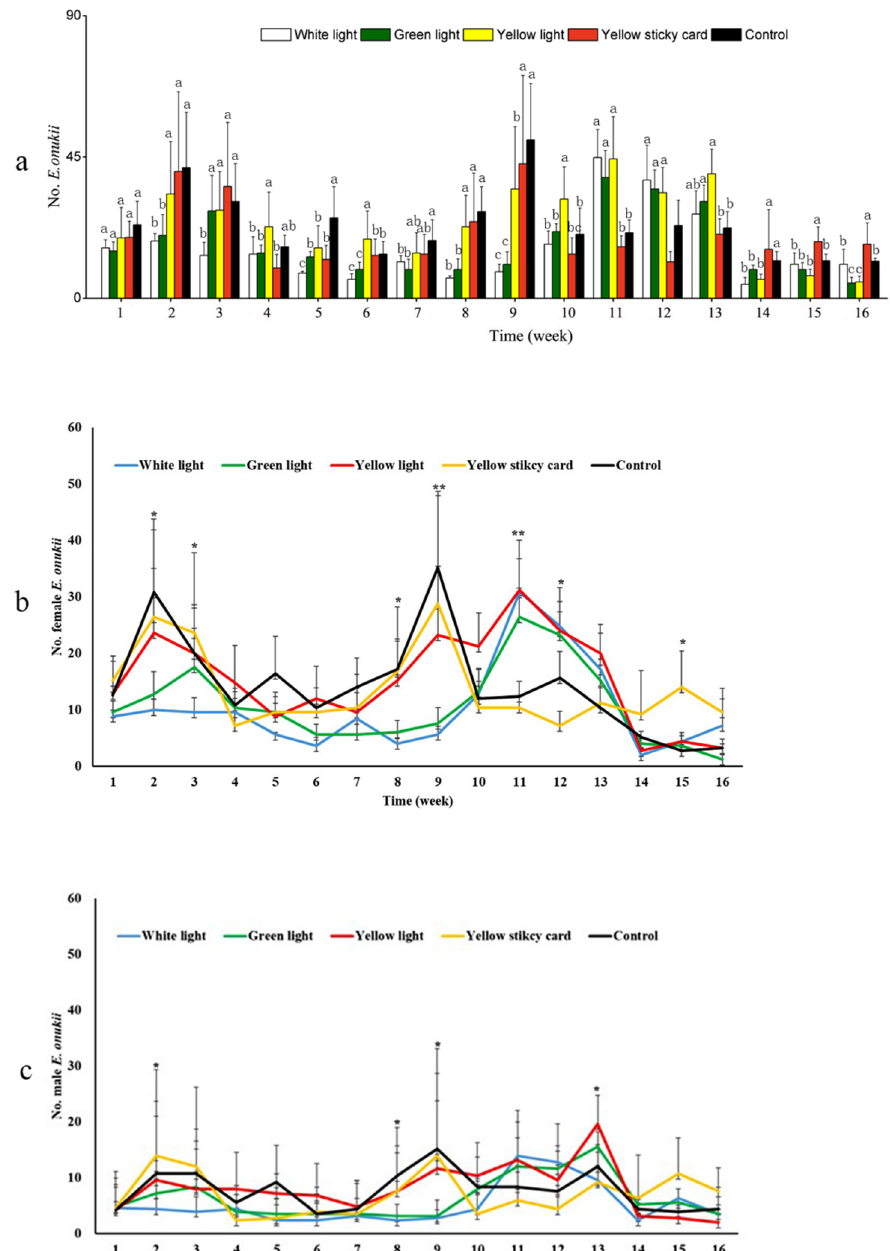
Figure 8. Population dynamics of total E. onukii ( a ), female ( b ) and male ( c ) in the five treatments in the exclosure experiment. Different letters within the same week represent significant differences based on a one-way ANOVA followed by an LSD test, p < 0.05; Significant differences based on a one-way ANOVA followed by LSD tests, *: p < 0.05; **: p < 0.001. The weekly collection lasted from 25 August to 8 December, for a total of 16 weeks.